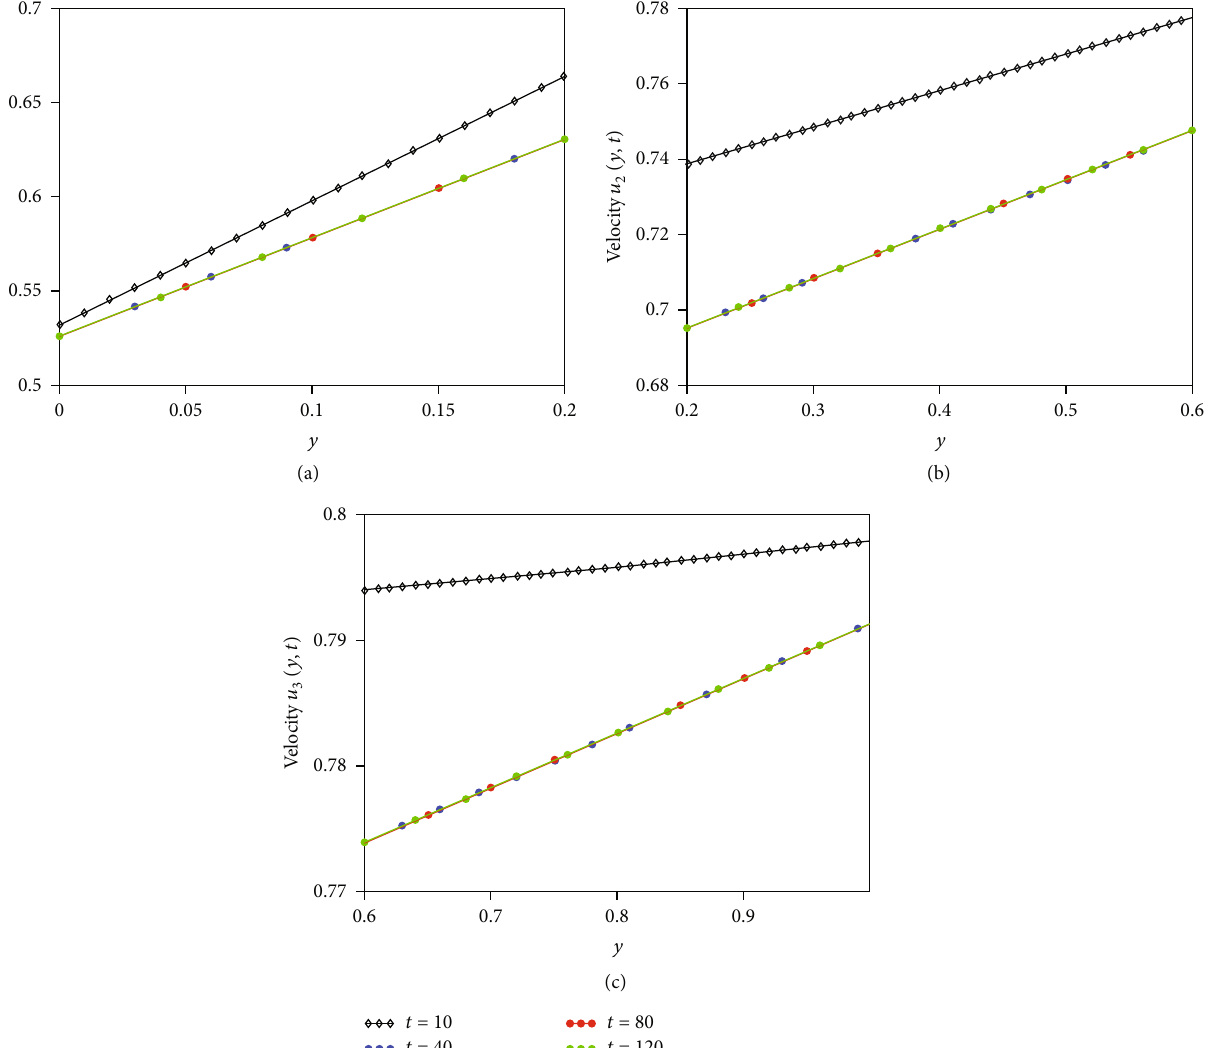
ð y , t Þ , i = 1, 2, 3 for large values of the time t ( α i = 1, b = 4, b = 12 , h = 0 : 2 , h 1 2 3 1